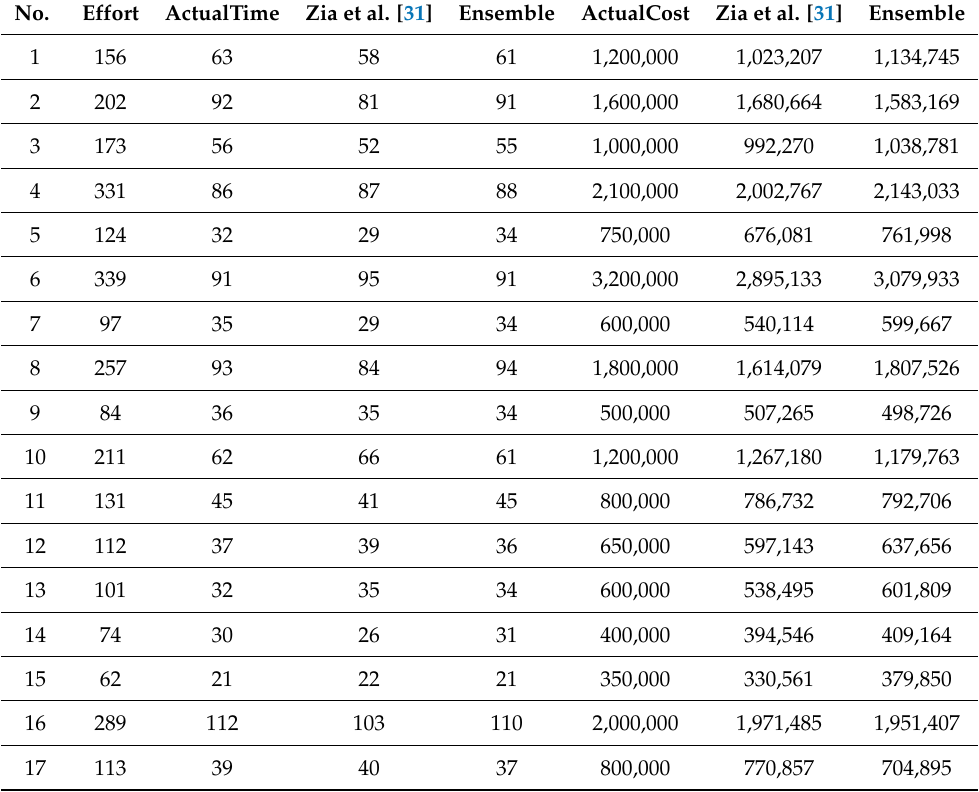
Table 14. Comparison results of original model versus proposed machine learning